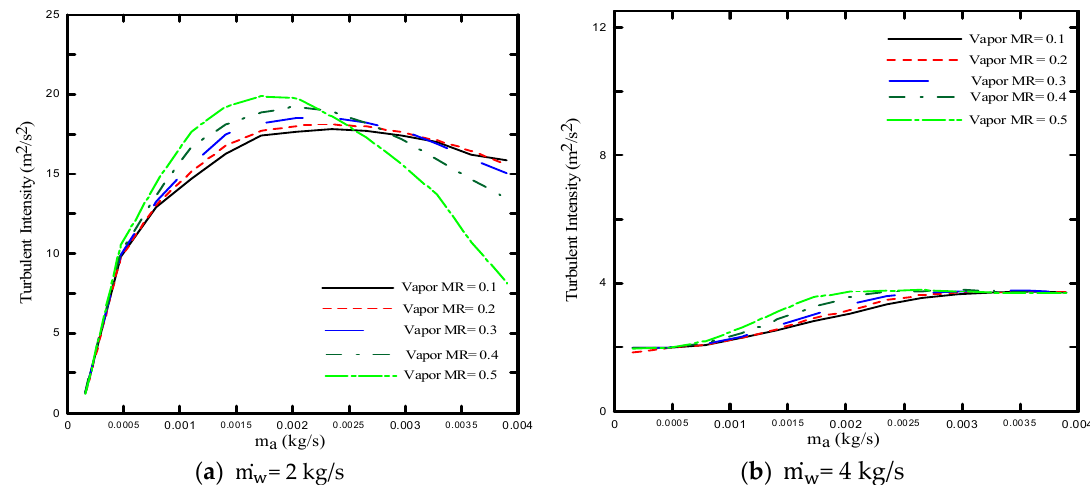
Figure 7. Effect of air and vapor mass flow rates on the static pressure generation in the tube upper region.